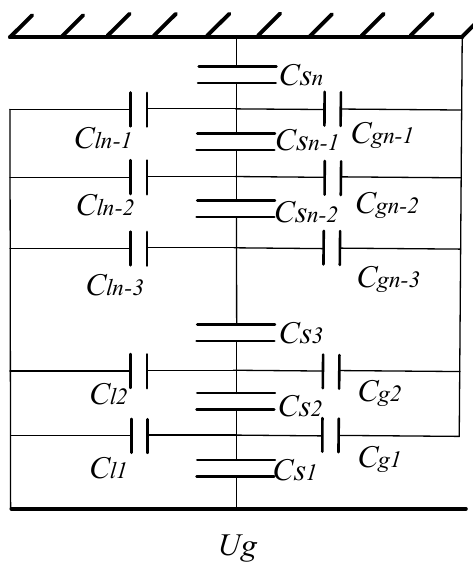
Figure 11. Equivalent circuit diagram of an insulator. The capacitance of insulators in the figure is C s 1 = C s 2 = . . . = C sn = . . . = C s 0 ; the ground capacitance is C g 1 , C g 2 , . . . , C gn . . . ; the capacitance to the transmission line is C l1